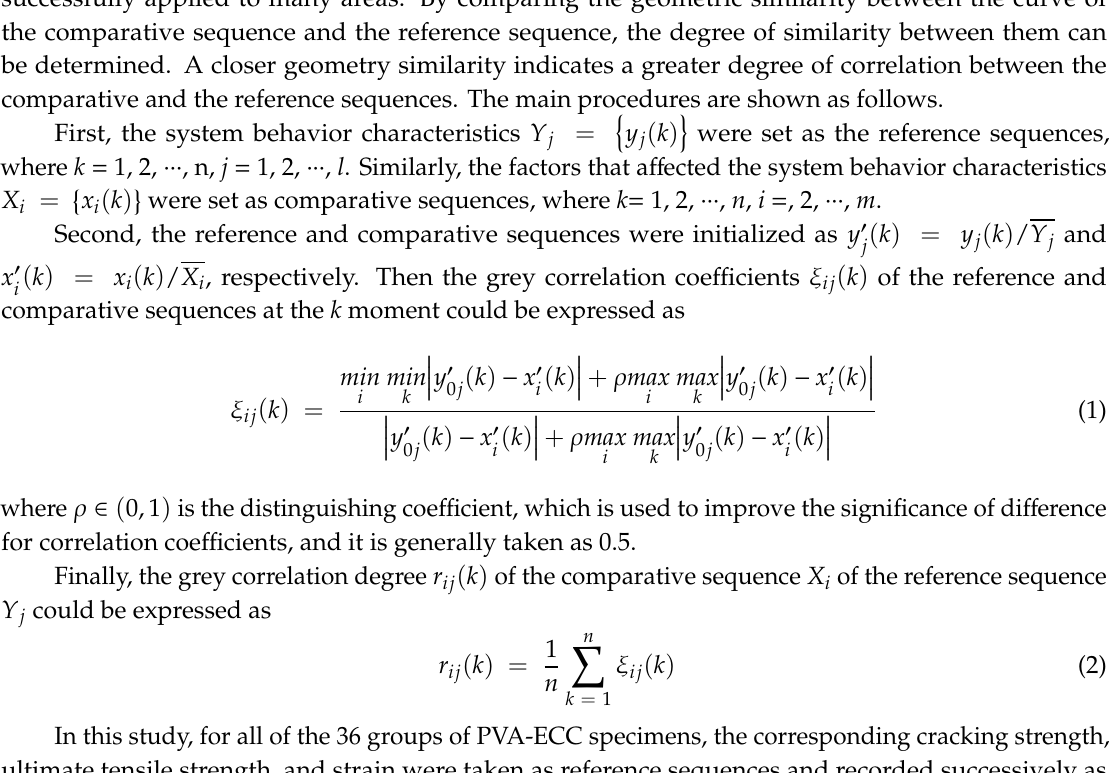
Table 6. Grey correlation degrees of the vibration factors on the tensile performance of PVA-ECC.